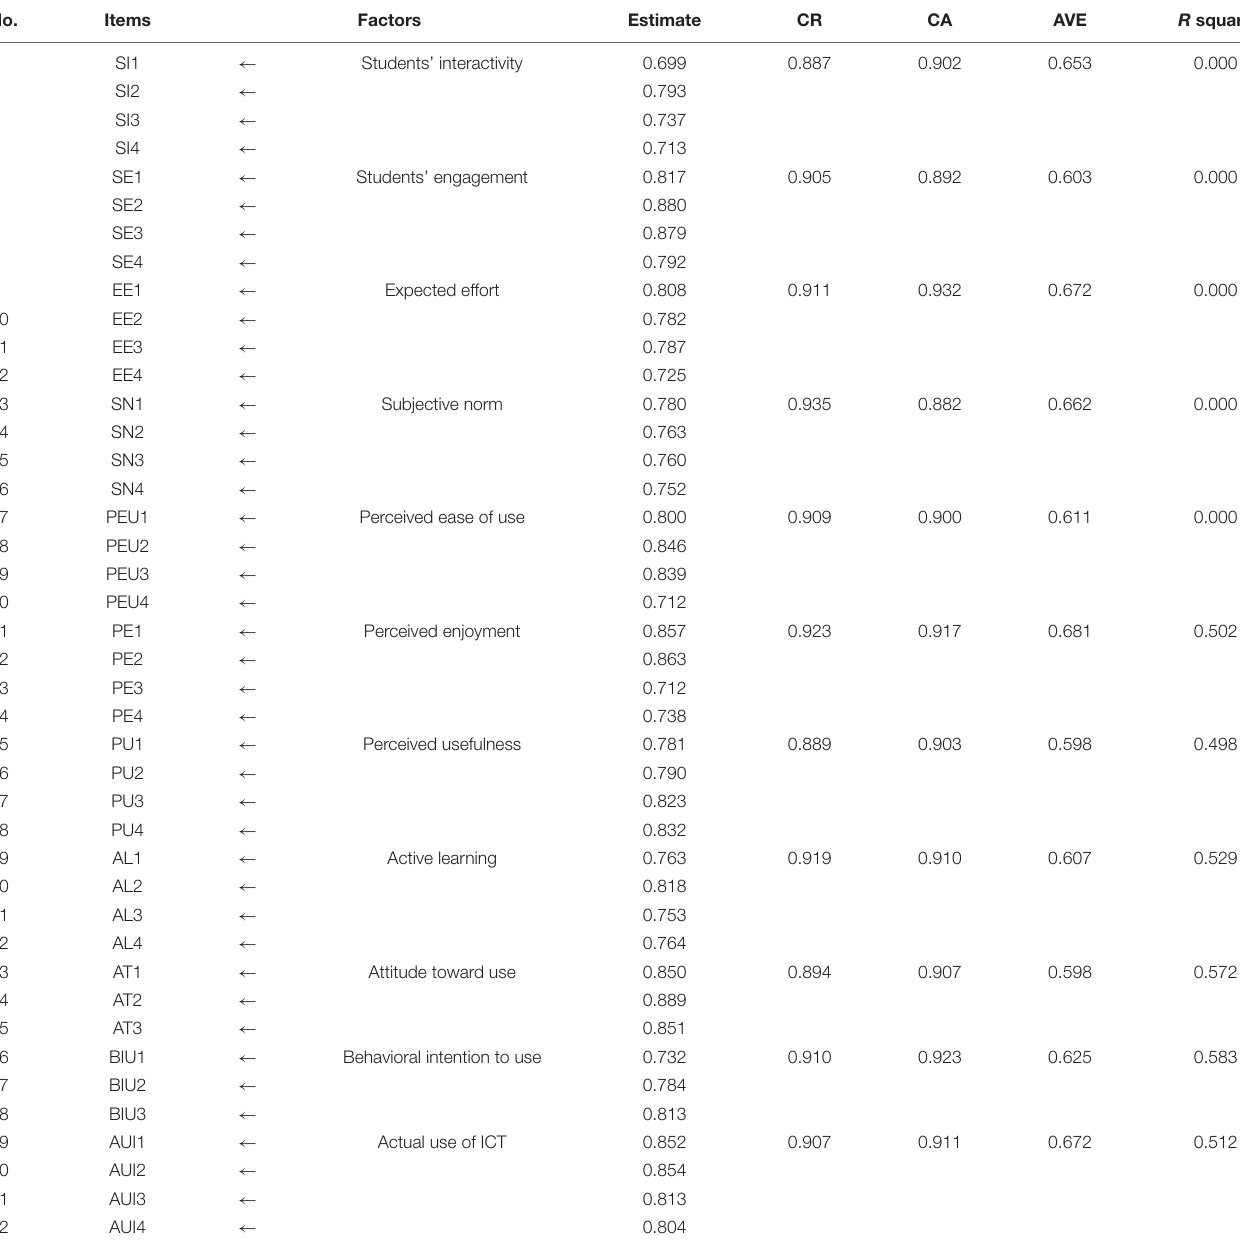
TABLE 4 | Reliability, validity, and measurement